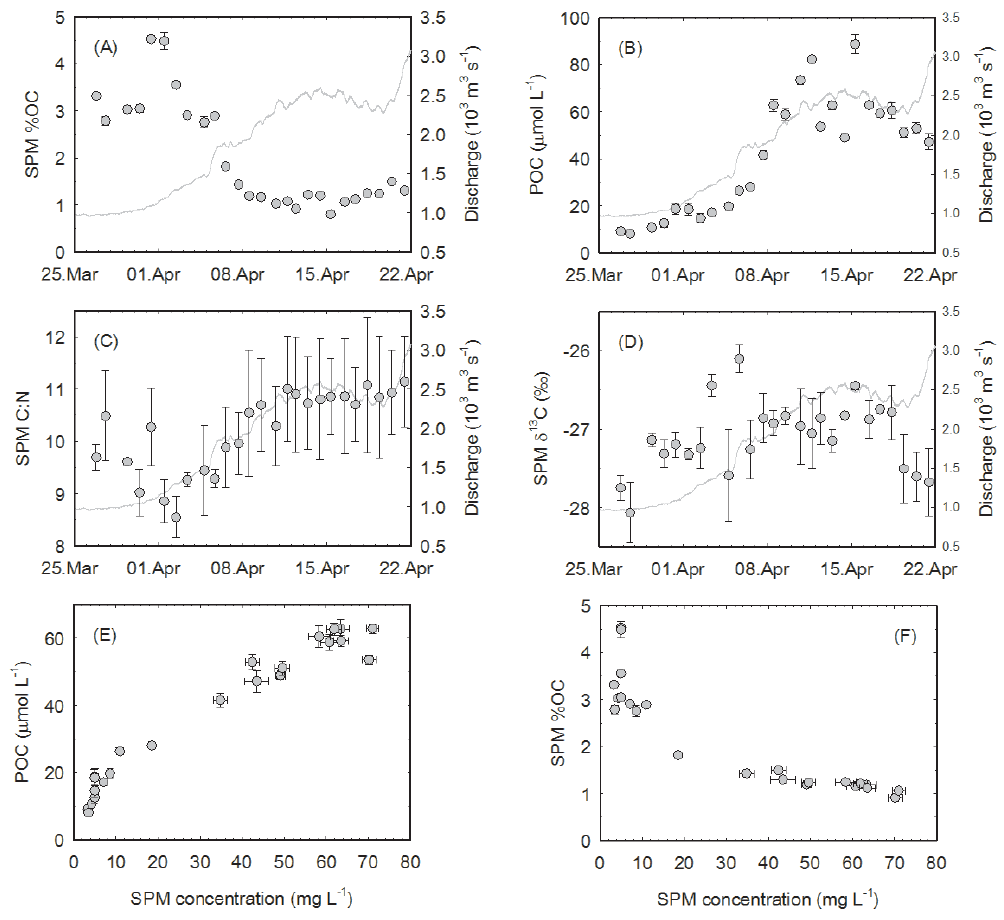
Figure 6. The abundance and composition of POC shifted during the early freshet period towards (a) relatively lower %OC, (b) higher POC concentration, and (c) higher C:N. (d) No distinct temporal trend is evident in δ 13 C. (e) POC concentration and (f) SPM OC content are tightly coupled with SPM concentration. Error bars represent 1 s.d. of triplicate measurements. Discharge is shown as gray lines in (a) – (d) .